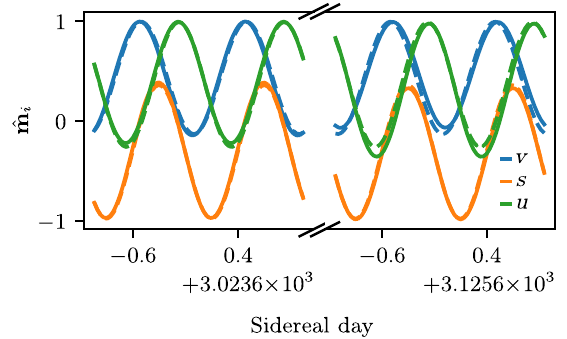
FIG. 14. Components s (orange), u (green), and v (blue) of the sensitive axis ˆ m over the entire time span of the experiment. Solid lines give the exact results, while dashed lines show fits of Eq. (B21) to the exact